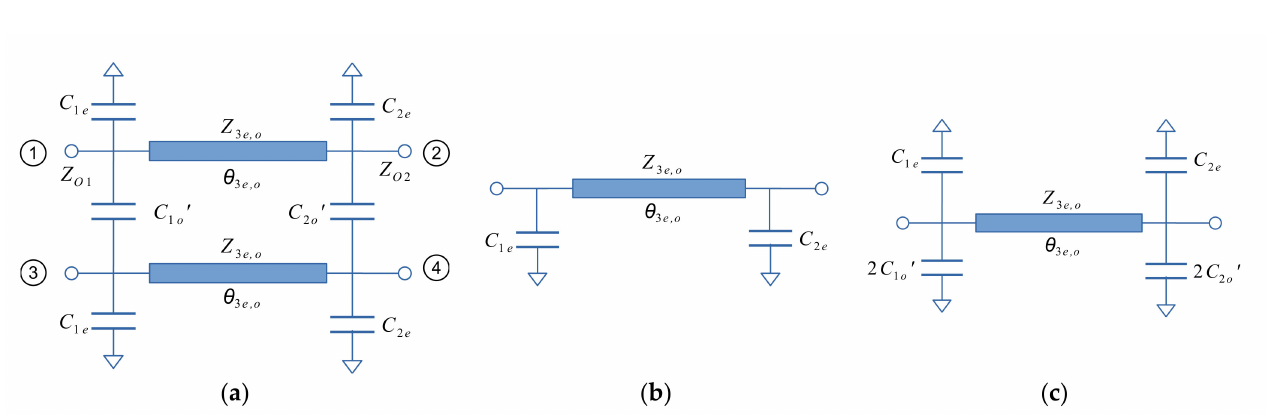
Figure 3. Lumped-distributed equivalent circuit of coupler: ( a ) Total equivalent circuit; ( b ) even-mode equivalent circuit; ( c ) odd-mode equivalent